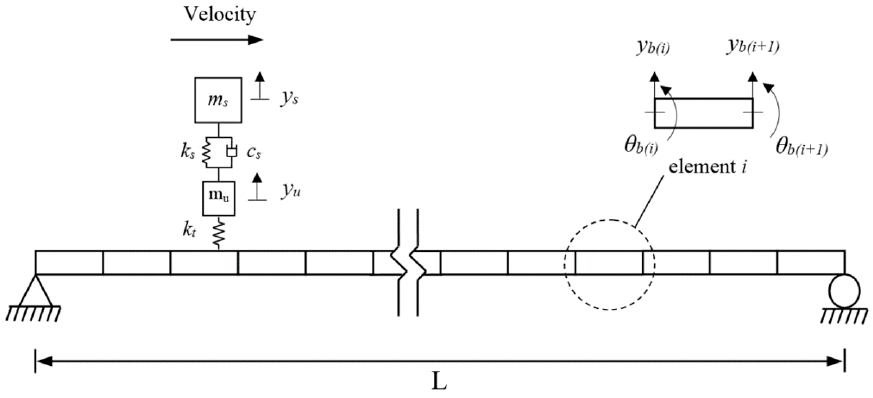
Figure 3. The vehicle–bridge interaction